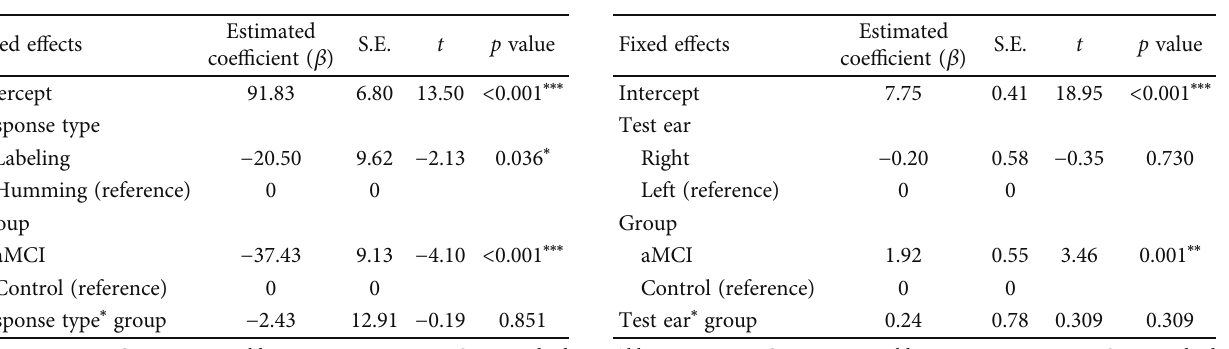
Table 2: Estimated fi xed e ff ects of predictors for frequency pattern test.